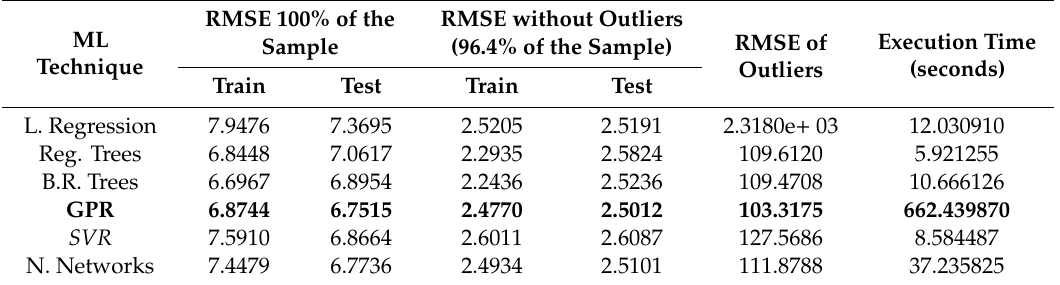
Table 6. BMI-CTDI VOL results for men’s Thorax, Abdomen, & Pelvis protocol.